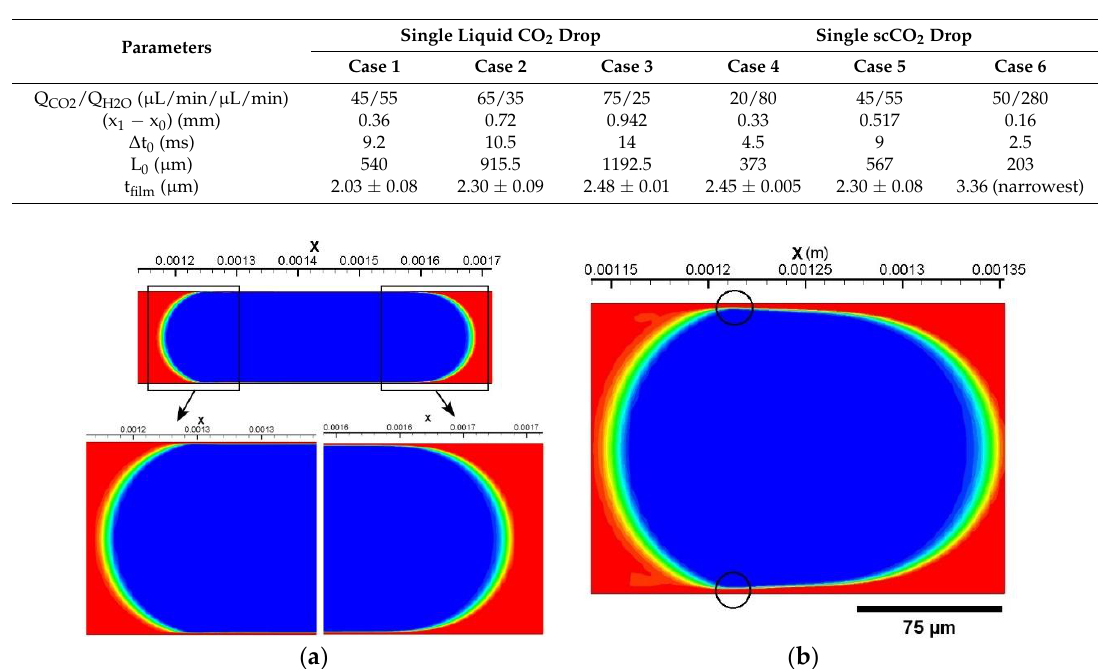
Figure 3. ( a ) A completely cylindrical CO 2 drop is further stabilized at t = 12.2 ms. ( b ) The drop profile of the scCO 2 drop in Case 6 at the end of the drop preparation stage. Two circles are added to indicate where the minimum film thickness is measured.